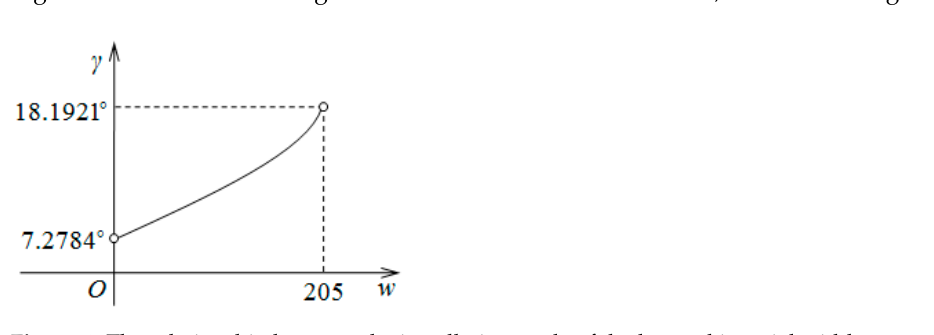
Figure 4. The relationship between the installation angle of the lug and its axial width. To verify the correctness of Equation (8), the values of the installation angle “ γ ” at different values of w are obtained by a ProE three-dimensional modeling test, and the results are compared with those calculated by Equation (8). The results are shown in Table 4.